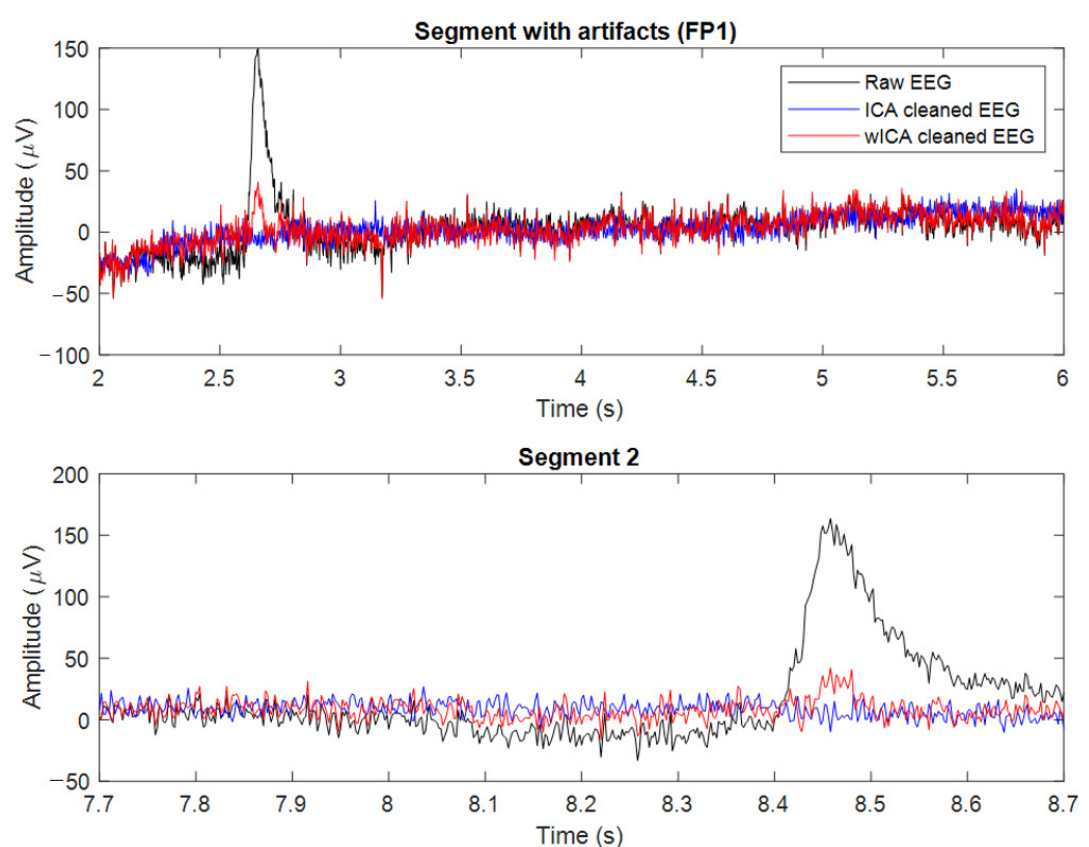
Figure 4. wICA-cleaned EEG from subject 8 for time segments of 4.0 and 1.0 s, respectively.